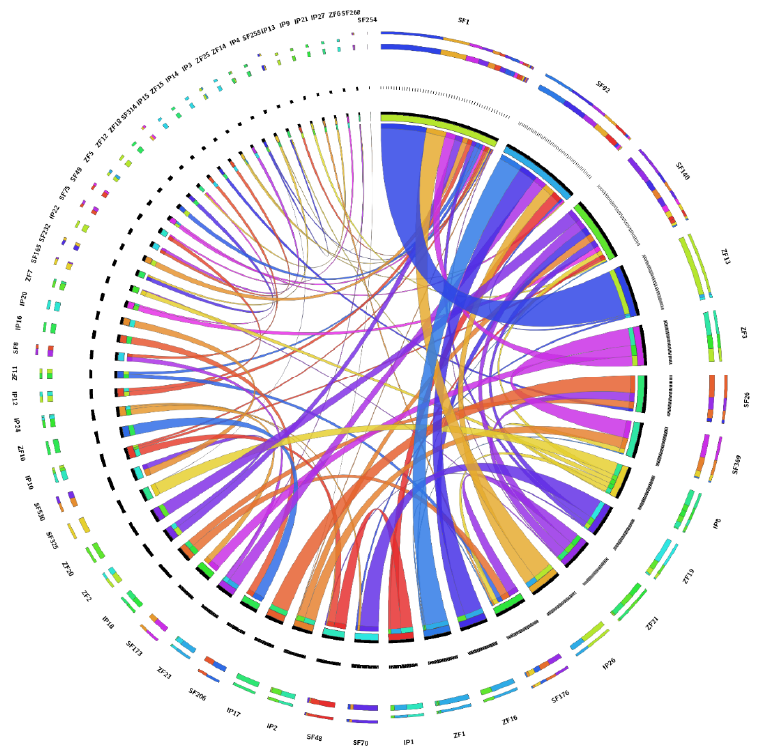
Figure 4. Synteny visualization of 45 genes present on 21 genome scaffolds of magur with channel catfish and zebrafish.